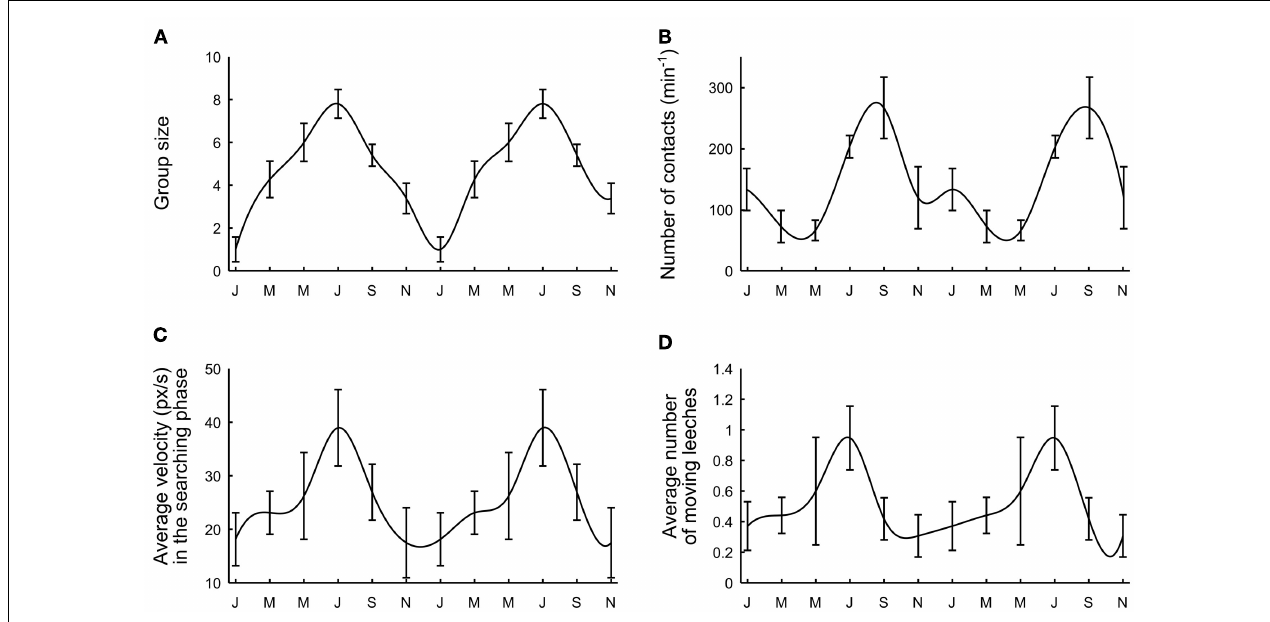
were averaged over periods of 3months. Letters on the time axis indicate months (January, March, May, July, September, November). Smooth curves through the data drawn by